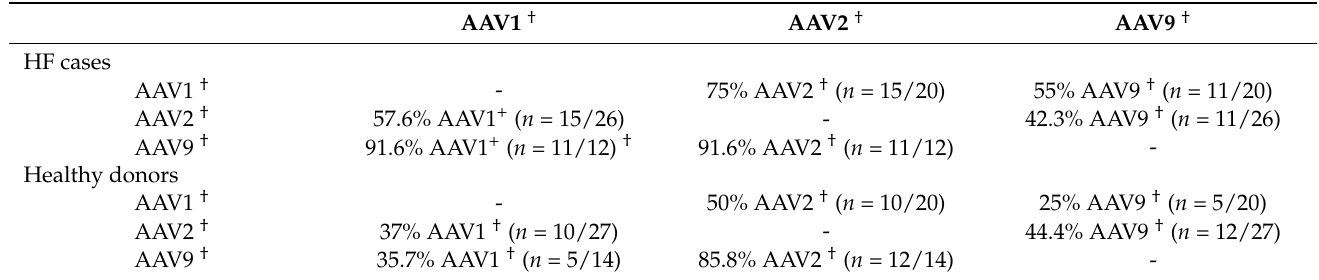
Table 2. Combined prevalence of NAb against AAV1, AAV2, and AAV9 in HF cases and healthy donors.